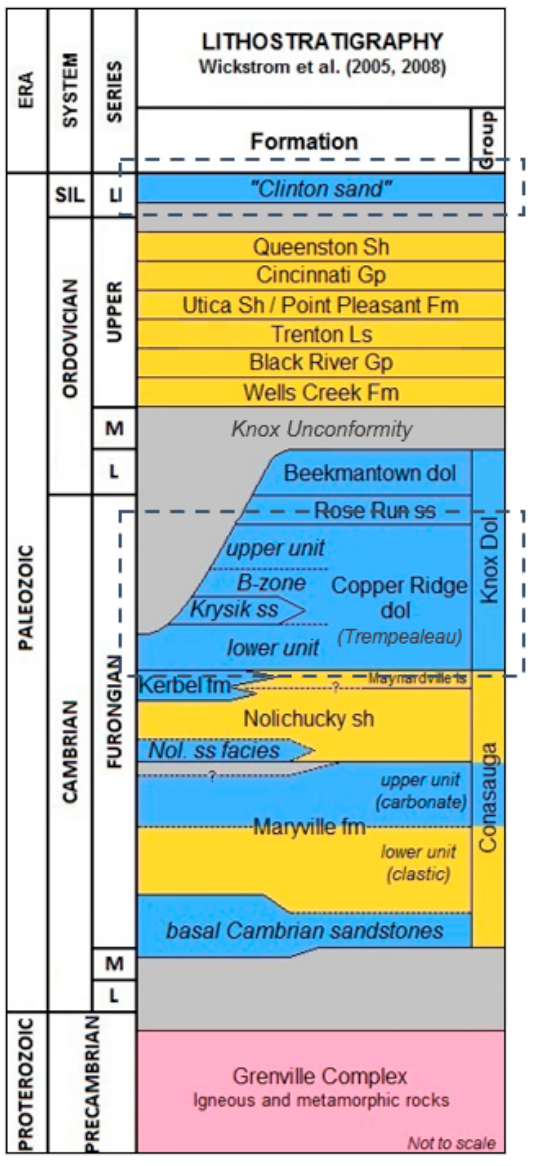
Figure 2. Generic lithostratigraphic column showing Ohio reservoirs. The two reservoirs of interest are indicated using dotted lines.